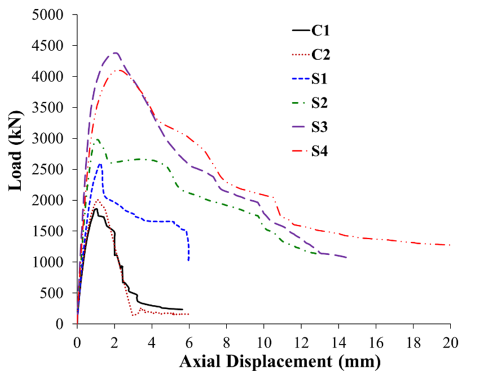
Figure 9. Load versus displacement curves for column specimens based on test results.